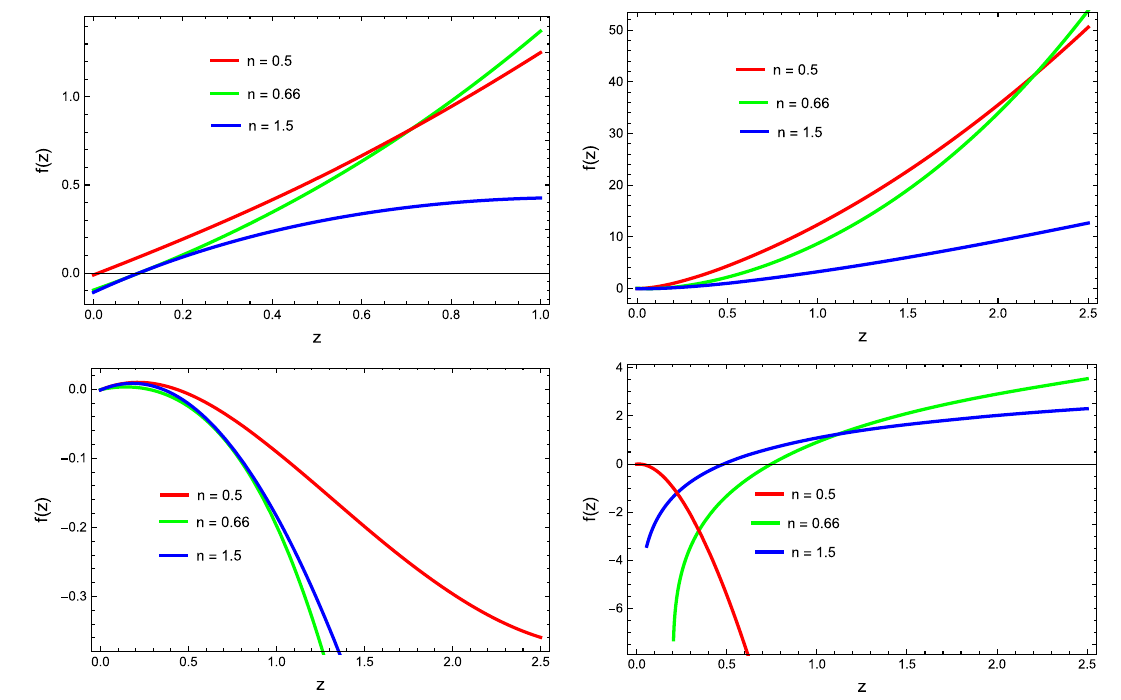
Fig. 1 Plots of power-law reconstructed GGPDE f ( R ) model for k = 1 (upper plane) and k = − 1 (lower plane) with η = 0 . 99 (left) and η = − 0 . 99 (right)